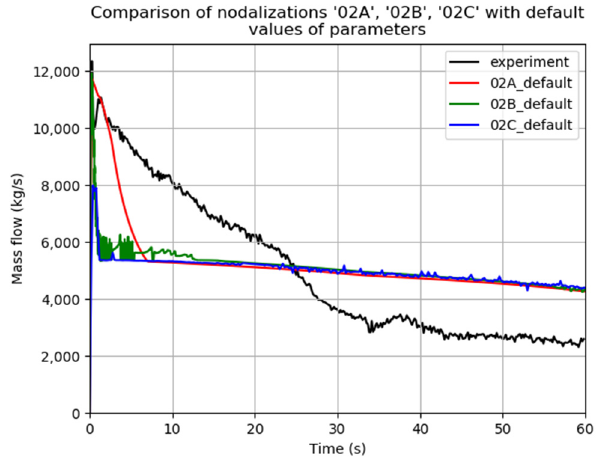
Figure 2. Mass flow rate for the models with 2 CV 02A, 02B, and 02C nodalizations compared with the experimental data.